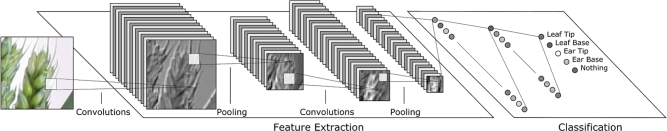
A simplified example of a CNN architecture operating on a fixed size image of part of an ear of wheat. The network performs alternating convolution and pooling operations (see the online methods for details). Each convolutional layer automatically extracts useful features, such as edges or corners, outputting a number of feature maps. Pooling operations shrink the size of the feature maps to improve efficiency. The number of feature maps is increased deeper into the network to improve classification accuracy. Finally, standard neural network layers comprise the classification layers, which output probabilities for each class.